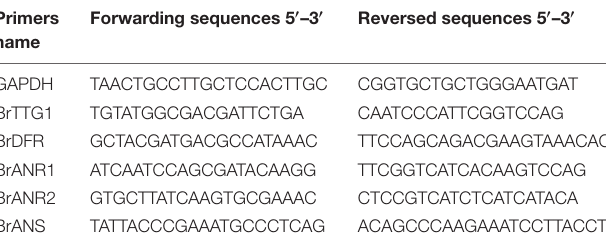
TABLE 1 | All primers sequences for quantitative real-time